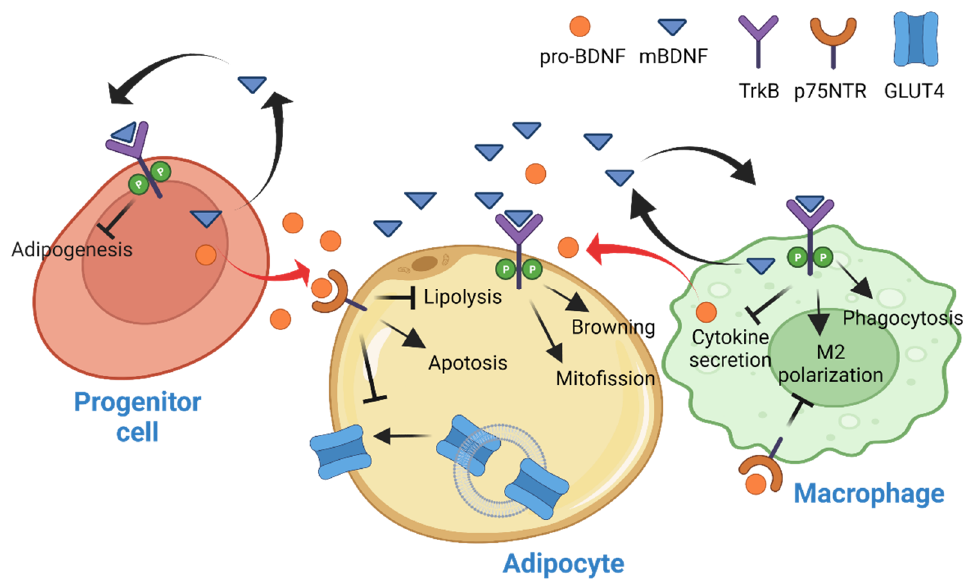
Figure 3. Functional activities of mBDNF and pro-BDNF in the white adipose tissue. The mBDNF and pro-BDNF are mainly synthesized by the progenitor cells and macrophages, which act on the mature adipocyte to modulate its metabolism. The BDNFs might also act as an autocrine to modulate the differentiation of pre-adipocytes and the transformation of macrophages.